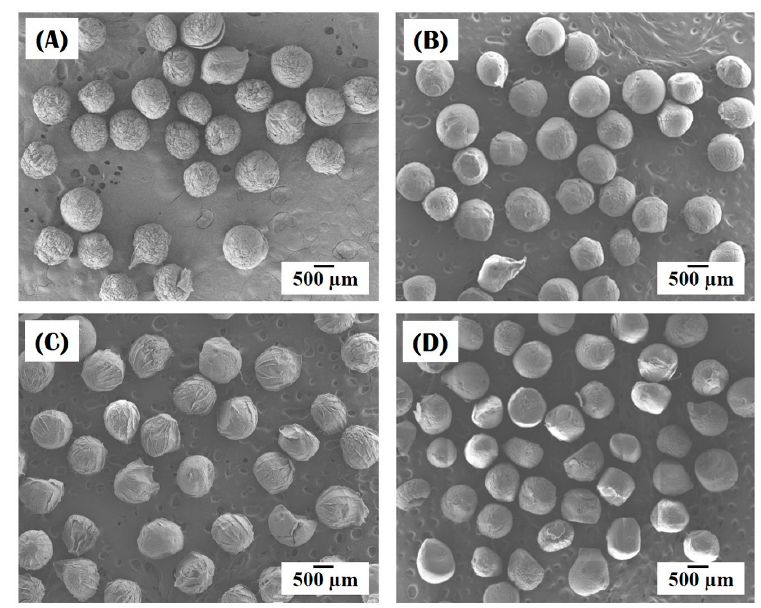
Figure 2. Representative field emission scanning electron microscopy (FE-SEM) images of the morphology of nanofibrous collagen/HA composite microspheres synthesized with different levels of HA: ( A ) 0 wt %; ( B ) 10 wt %; ( C ) 15 wt %; ( D ) 20 wt %.